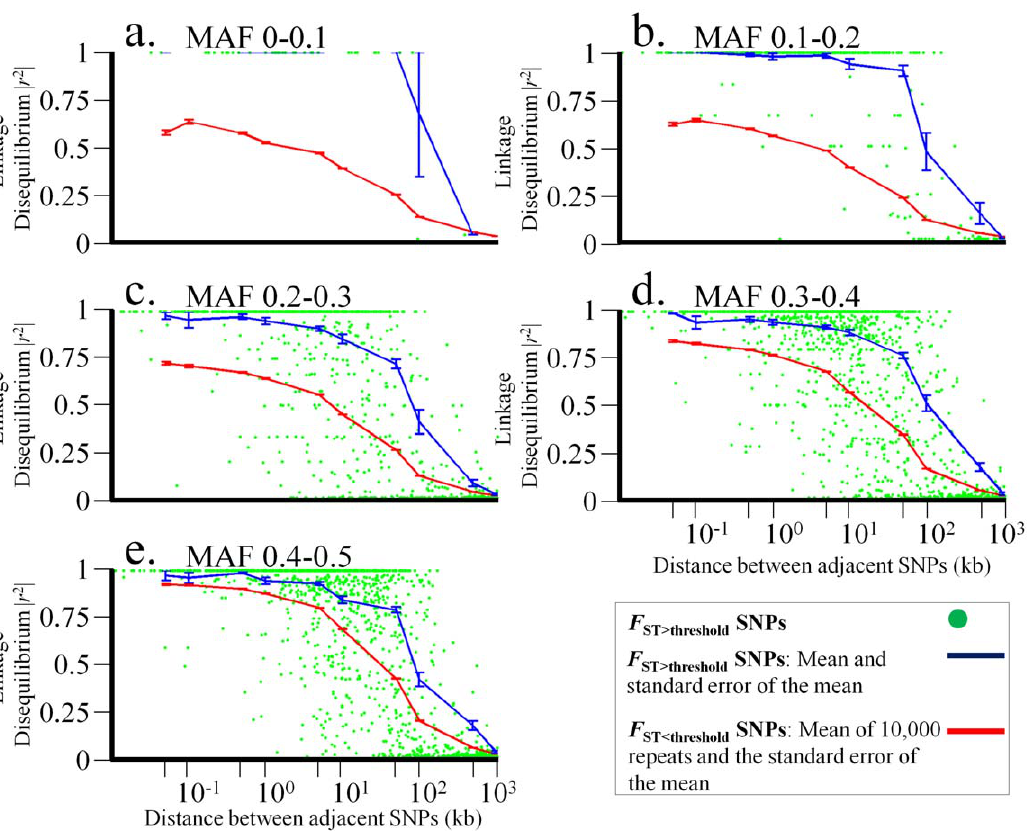
Figure 8. LD for five allele frequency groups as a function of physical distance in Africans. LD ( r 2 ) in African populations is plotted as a function of physical distance on a log-scale for five allele frequency groups (a–e). To simplify the presentation, the mean and standard error of the mean r 2 for the F ST . threshold SNPs (blue) and F ST , threshold (red) are presented for different between-SNP distances (50 bp, 100 bp, 1 kb, 5 kb, 10 kb, 50 kb, 100 kb, 500 kb, and 1000 kb). F ST . threshold SNPs are marked as green dots.